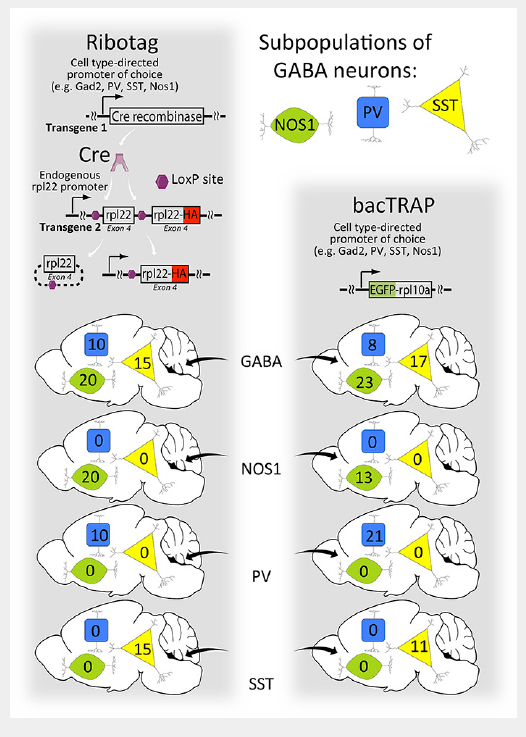
A comparison of Ribotag and bacTRAP methods. In the left pathway, a ubiquitous promoter drives expression of the Ribotag (rpl22-HA) protein only after Cre recombinase activity releases the inhibition of Ribotag expression. The endogenous rpl22 exon 4 functions as a ‘floxed STOP’ for the Ribotag method, as shown in fig. 4. The cell type specificity is determined by the pattern of Cre expression. Therefore, the same cell targeted by different Cre activators will have the same expression level of the Ribotag protein because the same ubiquitous promoter drives its expression from the same place in the genome. In contrast (right pathway), different promoters drive the expression of bacTRAP resulting in different expression levels in this hypothetical example. An important advantage of bacTRAP is that one mouse line is needed versus two for